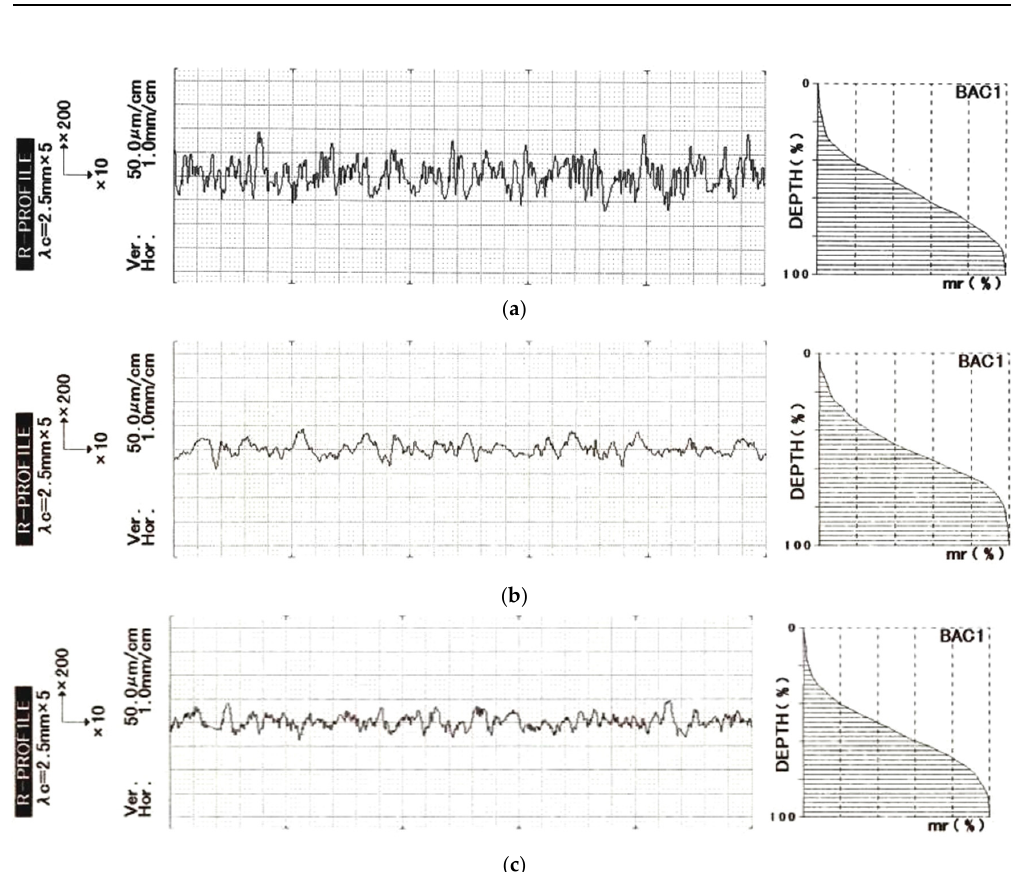
Figure 12. Profiles of materials as-made and blasted. ( a ) as-made; ( b ) Zirblast, 0.6 MPa; ( c ) White corundum, 0.6